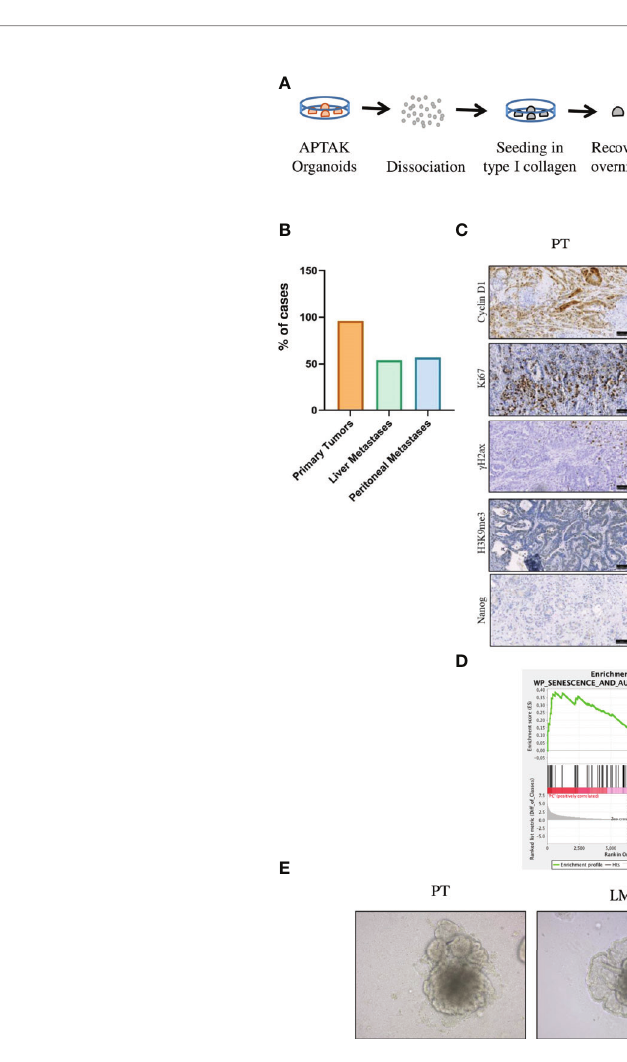
FIGURE 2 | The orthotopic transplantation of APTAK organoids leads to both liver metastases and PC but only cancer cells in the peritoneal cavity show induction of senescence. (A) Schematic protocol of the orthotopic transplantation of APTAK organoids under the serosa of the cecum. (B) Quanti fi cation of primary tumors (98%, n = 27), liver metastases (54%, n = 15) and PC (57%, n = 16) about 42 days after orthotopic transplantation of APTAK organoids. (C) Representative images of IHC staining for the proliferation markers Cyclin D1 and Ki67, the DDR marker g -H2AX, the senescence marker H3K9me3 and the stem cell marker Nanog in primary tumors (PT), liver metastases (LM) and PC. Scale bar: 50 µm (D) Gene set enrichment analysis (GSEA) of senescence and autophagy markers in PC versus primary tumor samples (n = 3 per group). (E) Representative images of tumor organoids cultured as 3D culture at d5 derived from tumors (primary tumor (PT), liver metastasis (LM) and peritoneal carcinomatosis (PC)) of the same mouse in the orthothopic organoid transplantation model. Magni fi cation